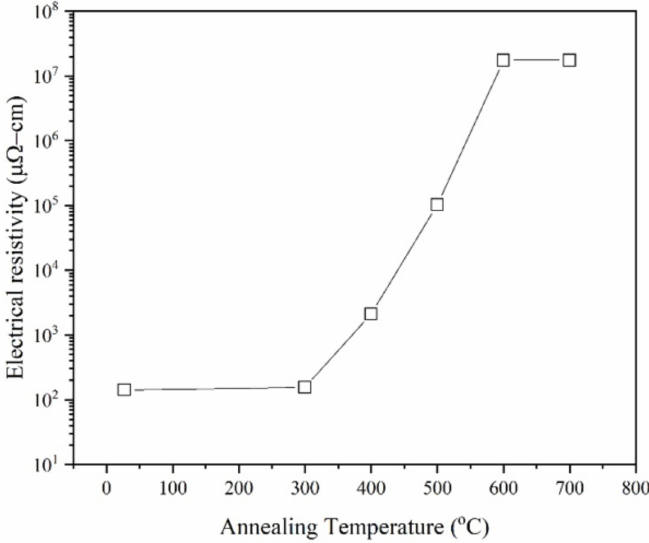
Figure 9. Electrical resistivity of (CrTaTiVZr)N coatings after annealing at di ff erent temperatures in